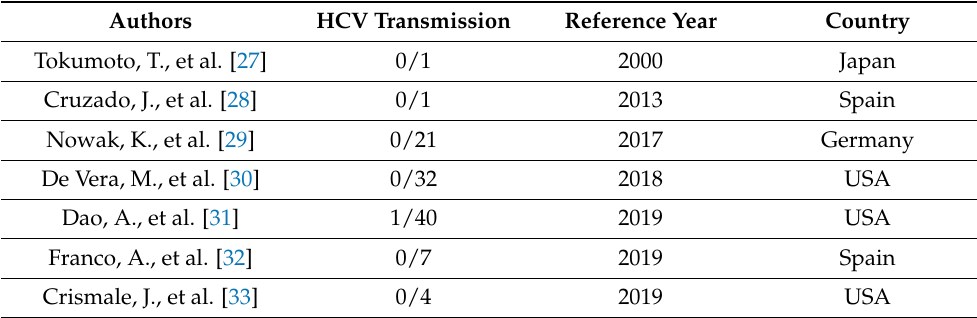
Table 2. Kidney transplant from anti-HCV-positive/non-viremic (HCV nucleic acid testing (NAT)- negative) donors into HCV-negative recipients: transmission of